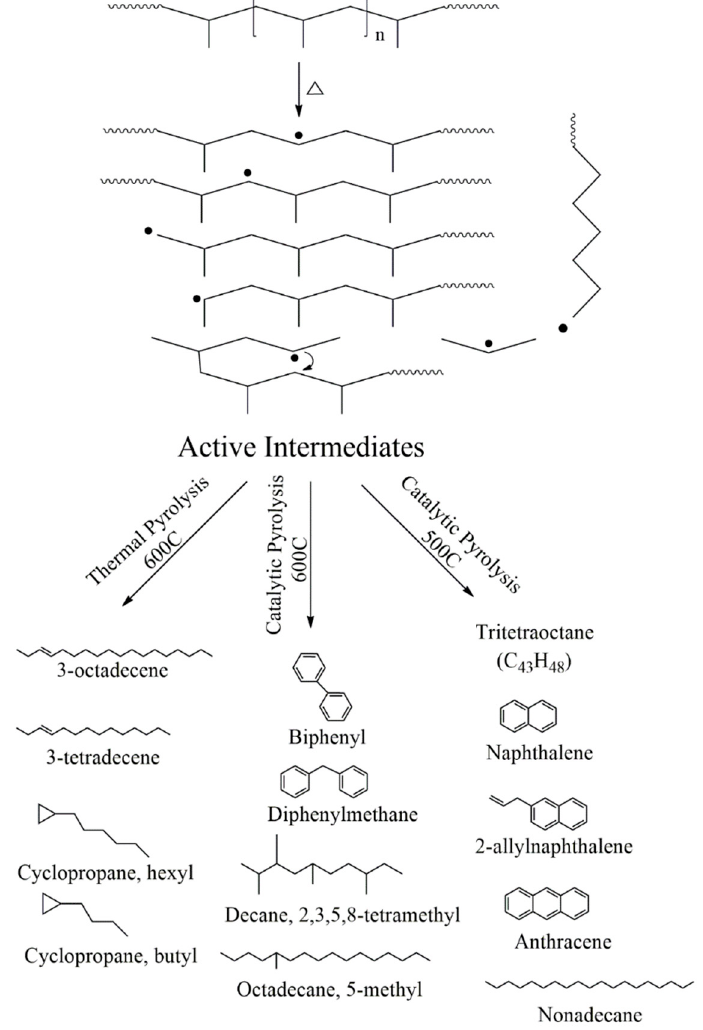
Figure 3. Reaction mechanism for the noncatalytic and catalytic pyrolysis of polypropylene present in prescription medicine bottles [45,46].